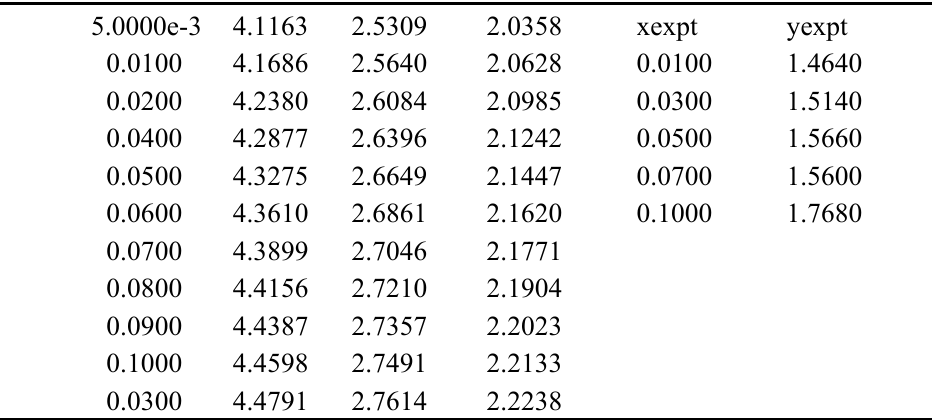
Table 5. Numbers used for plotting Figure 9 for experimental results vs. single electrode e.m.f.s, with  H2O